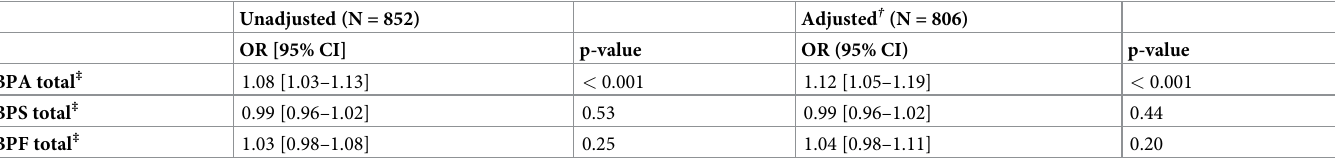
Table 2. Odds ratios (ORs) [95% confidence interval (CI)] of diabetes or prediabetes for an increase of 0.1 units in log-transformed urinary concentrations of bisphenols ( μ g/L) in logistic regression